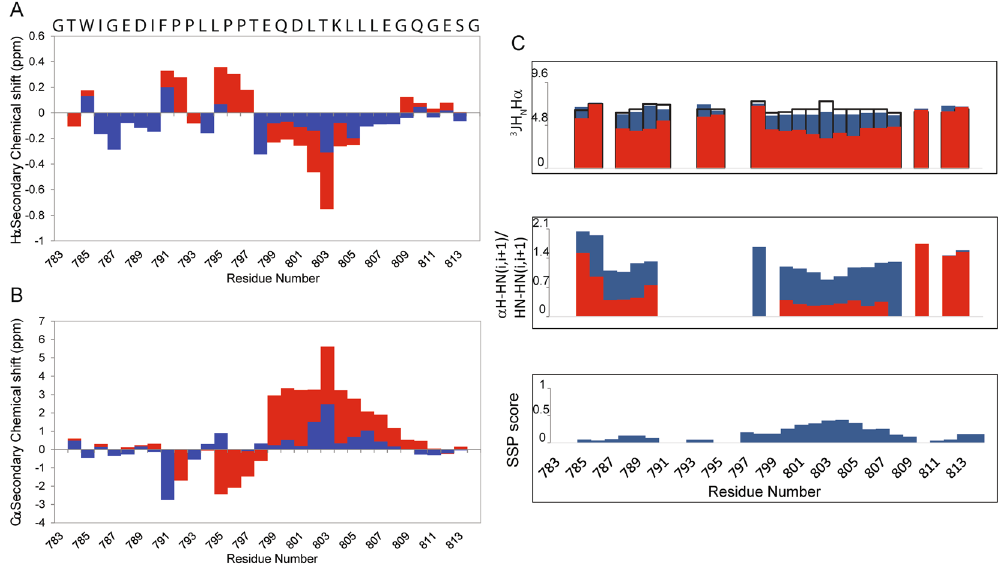
Figure 2. Secondary structure propensity analysis of STAT6 783–814 . ( A,B ) Secondary chemical shifts of H α ( A ) and C α ( B ) for the STAT6 783–814 peptide in the free (blue) and bound (red) state. ( C ) 3 JH N H α coupling constants ( upper ) and the intensity ratio of α H-HN(i,i + 1)/HN-HN(i,i + 1) NOEs ( middle ) for the STAT6 783–814 peptide in the free (blue) and bound (red) state. The open bars indicate the reference 3 JH N H α values in the random coil conformation 17 and the reference values of the intensity ratio of α H-HN(i,i + 1)/HN-HN(i,i + 1) NOEs are: 1.4 for random coil, 0.25 for α -helix and 55 for β -strand 17 . The SSP score (Secondary structural propensity) ( lower ) of the free STAT6 783–814 peptide is also